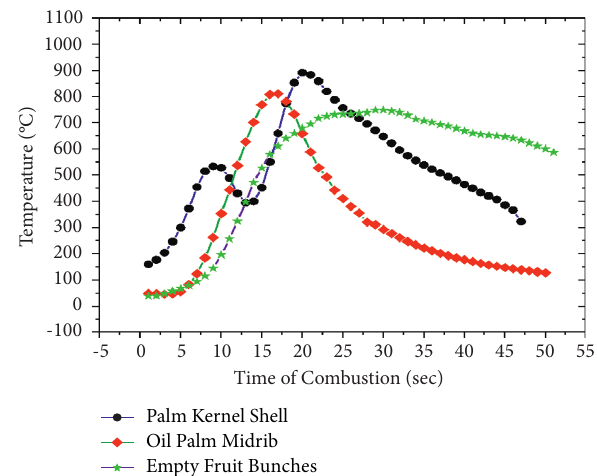
Figure 7: Profile temperatures for different fuels at the mea- surements